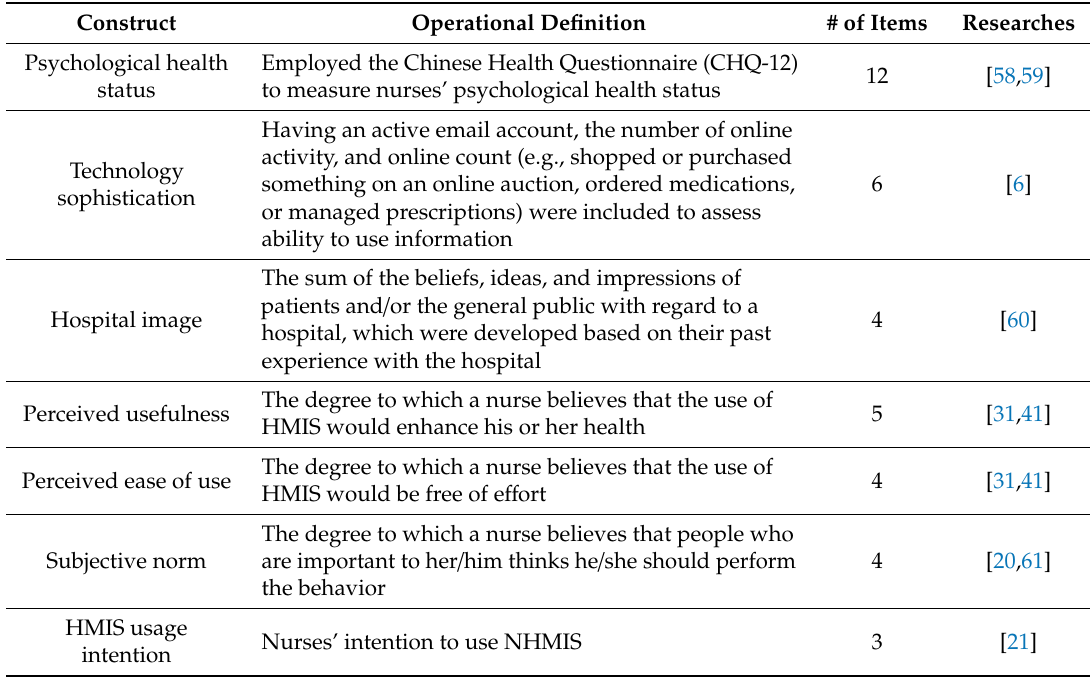
Table 1. Research Operational